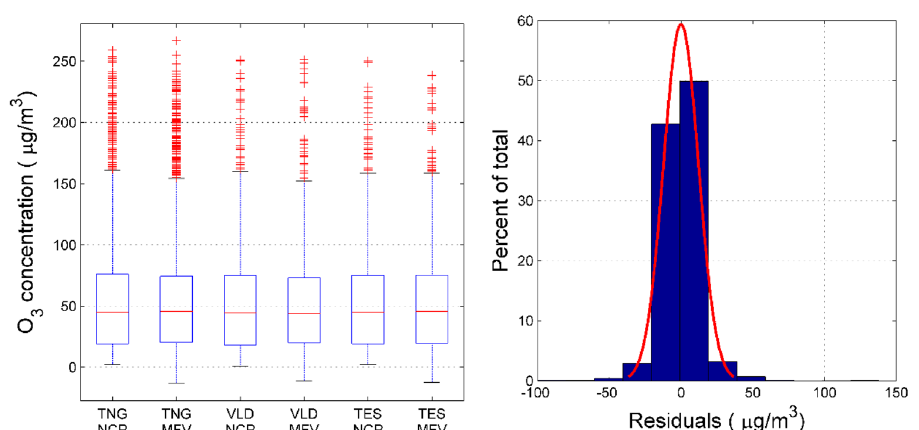
Figure 7. Residual test of LASSO-NARX model. Compare the national control point (NCP) measurement value and the model fit value (MFV) on the training set (TNG), validation set (VLD) and test set (TES) is seen on the left. The histogram of the residuals is seen on the